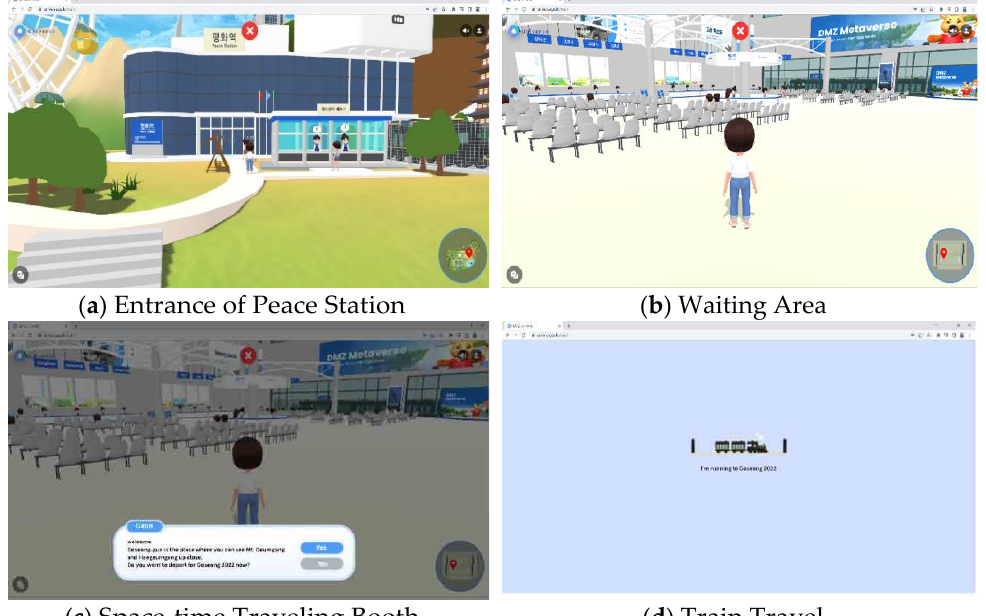
Figure 14. Peace Station.